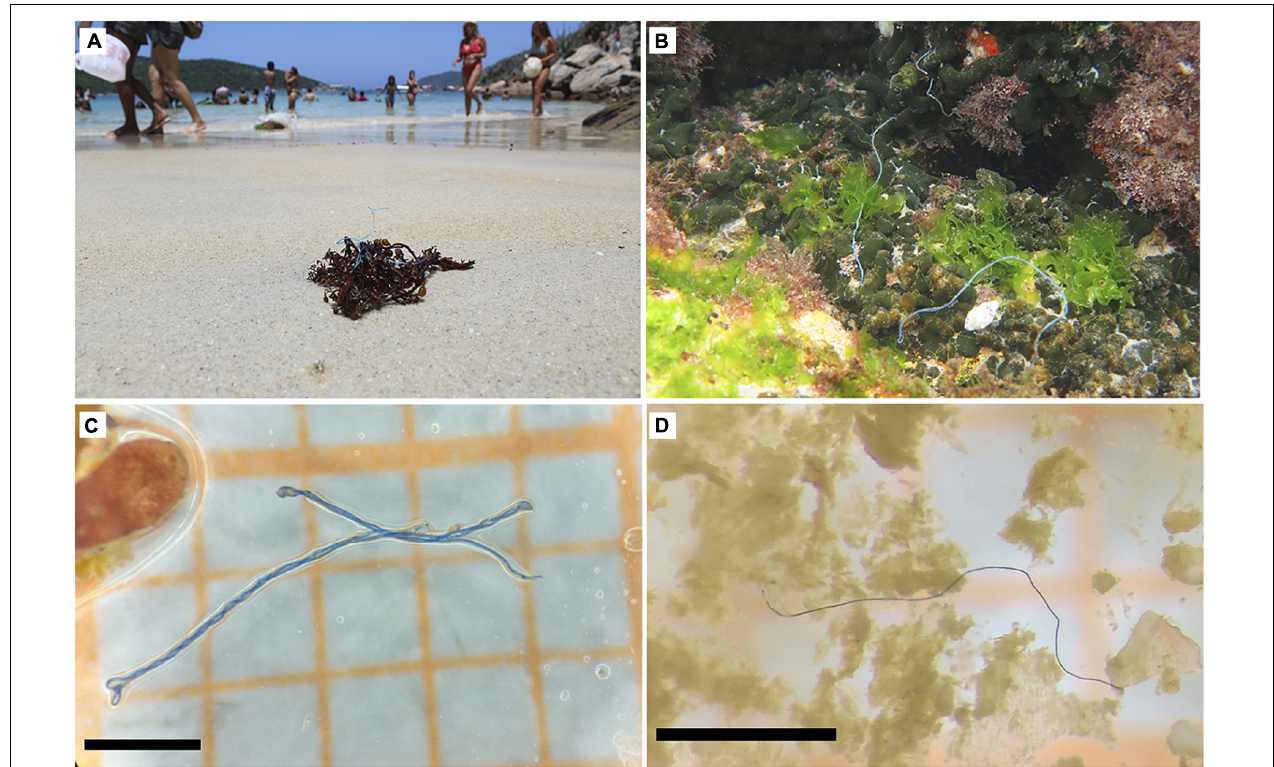
FIGURE 3 | Similarity between fibers observed in the wild – attached to algae stranded on the beach (A) and on the reefs (B) of one of the sampling locations (Arraial do Cabo) – and found in the stomach contents of study species (C,D) . Black scale bars in C,D represent 1 mm length. Photos by (A) Ryan Andrades and (B) Larissa J.